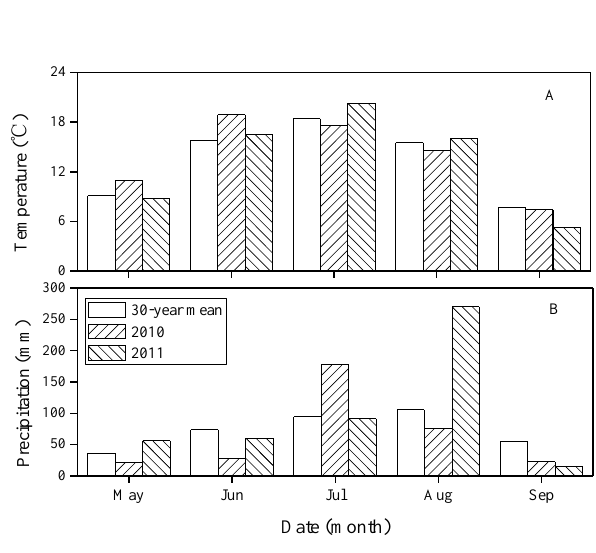
Fig. 1. Climatic characteristics of the study site during the growing season in 2010 and 2011 on the background of the long-term normal period (1980–2009) recorded by China Meteorological Administra- tion. (A) Monthly average temperature; (B) monthly accumulative